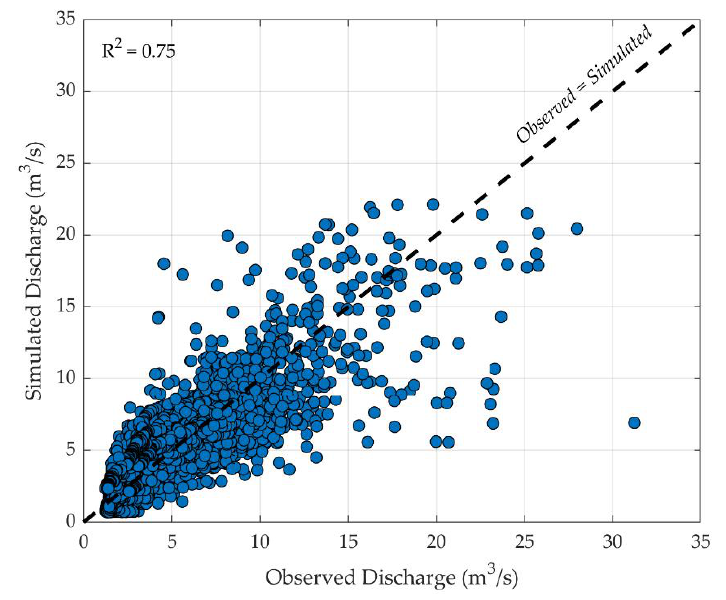
Figure 8. Scatter plot and coe ffi cient of determination (R 2 ) between the observed and simulated